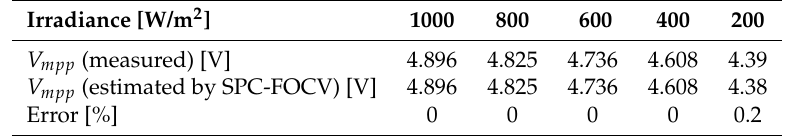
Table 4. Comparison between measured and estimated V mpp voltages for different irradiance values.